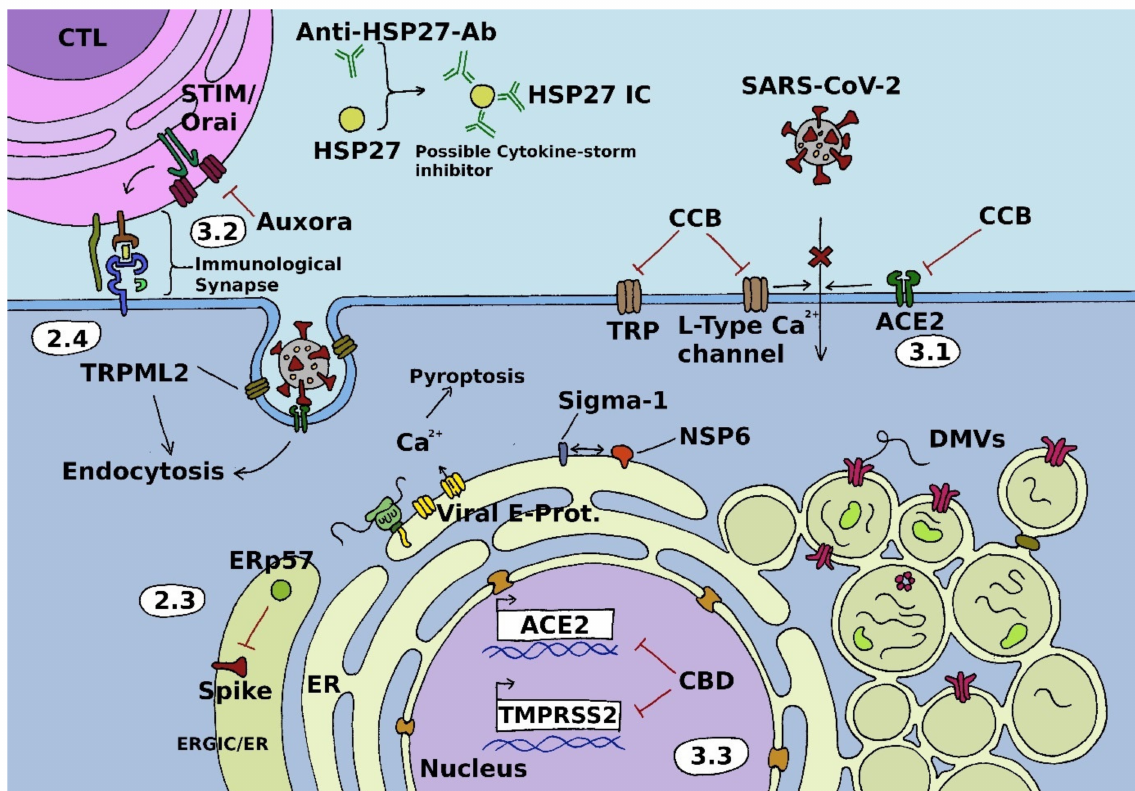
Figure 1. Strategies for inhibition of cellular calcium transport systems involved in viral infection cascades. Calcium levels dictate the activity of the NLRP3 inflammasome, eventually leading to pyroptosis of the cell. CCBs have been shown to interact with TRP, L-type Ca 2+ channels as well as ACE2 and thus have the potential to inhibit SARS-CoV-2 endocytosis. Auxora is a specific inhibitor of the STIM/Orai system, which has been implicated in inflammation-induced injury of pulmonary endothelial cells as well as proinflammatory cytokine storms that contribute to severe COVID-19 disease. There is evidence that TRPML2 channels have a role in the endocytosis of SARS-CoV-2 into host cells. Potential drugs designed for these channels could be strong tools in the treatment of COVID-19. CBD decreases expression of ACE2 and TMPRSS2, which are both integral players in SARS-CoV-2 infection. Double-membrane vesicles (DMVs) are derived from ER membranes and formed by non-structural proteins (NSPs) 3–6 to facilitate viral RNA replication in separate compartments, as it would be impaired by immune-responses in the cytosol. HSP27 vaccination might attenuate inflammation and increase tissue regeneration. Inhibition of ERp57 might impair correct spike-folding during virus replication. Knockout/knockdown of the Sigma-1 receptor has been shown to reduce viral replication, Numbers in bubbles denote sections describing the indicated proteins and mechanisms in